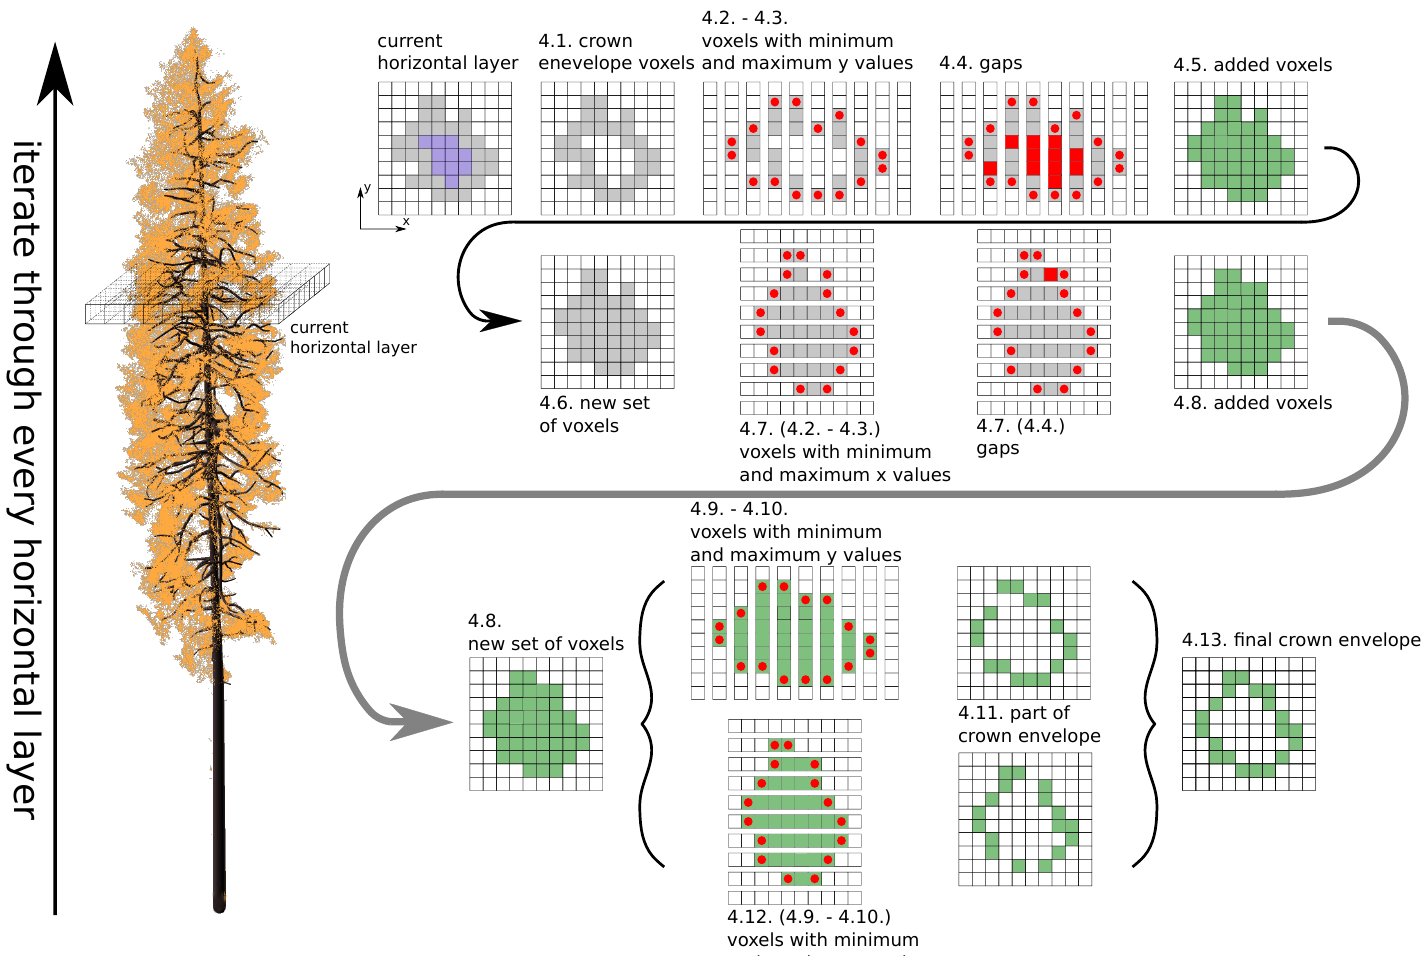
Figure A2. The process of crown envelope convexity corrections. This process describes in detail Step 4, consisting in finding the crown envelope. Corresponding steps 4.1. to 4.13 are presented